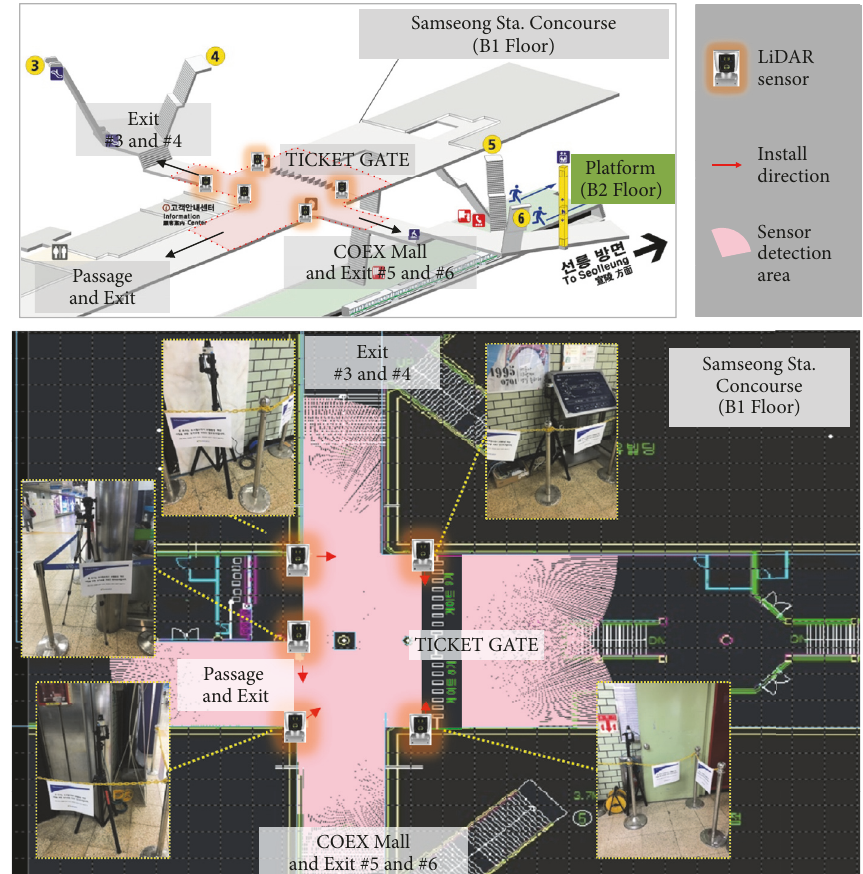
Figure 2: Data collection area. The area represents the first basement of the Samseong station. The five overlaid photos show the installation of the LiDAR sensors.